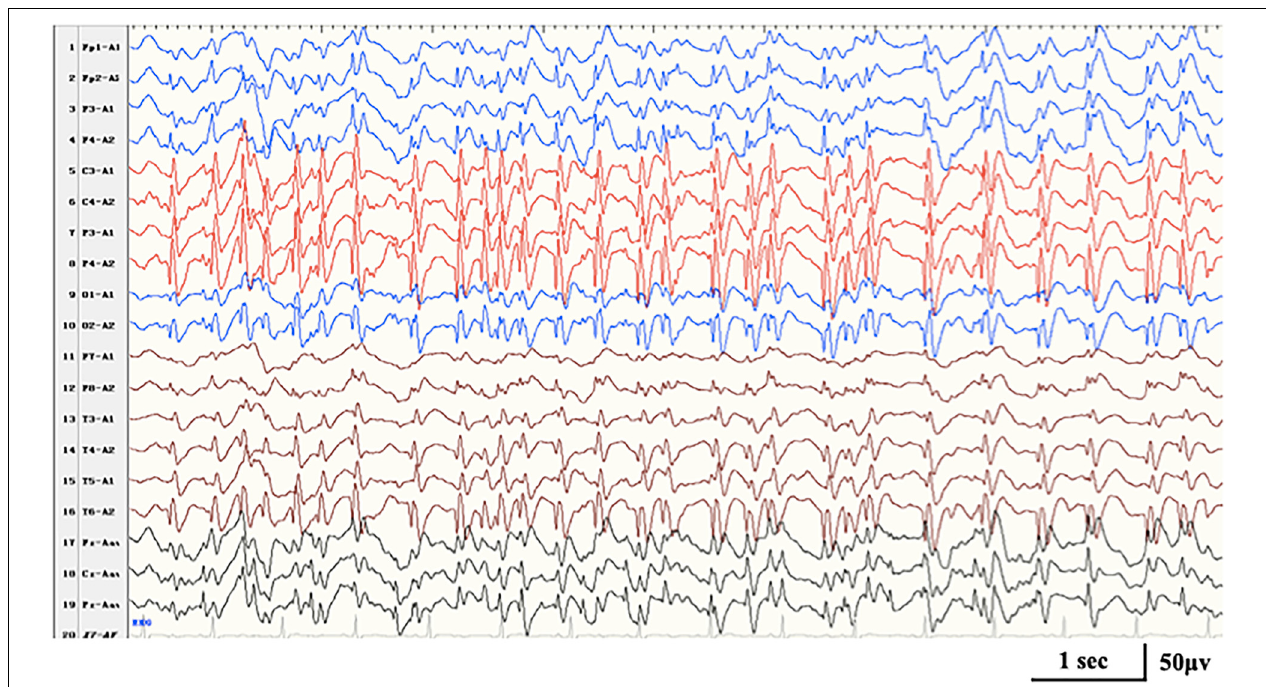
FIGURE 3 | Interictal EEG in case 16 with HIVEP2- related disorders at the age of 7 years, demonstrating generalized spike-and-wave with Rolandic predominance during NREM sleep (SWI 90%).